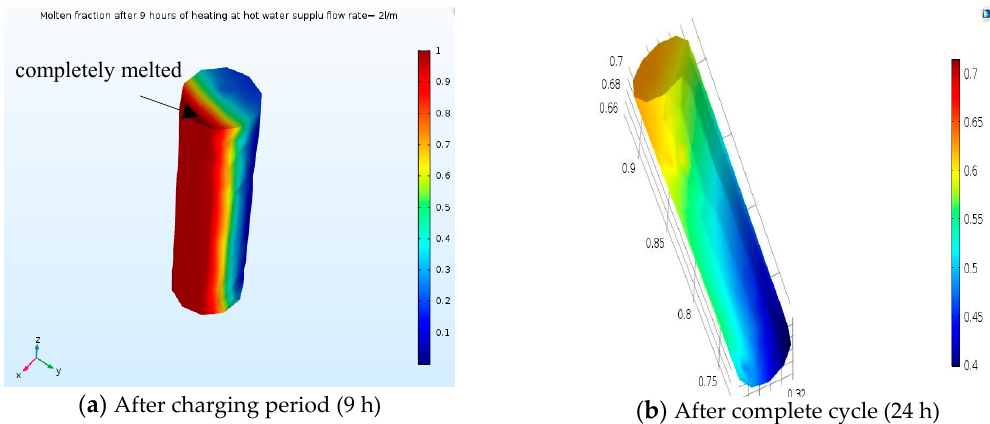
Figure 6. Melting fraction of phase change material after discharge period (24 h).